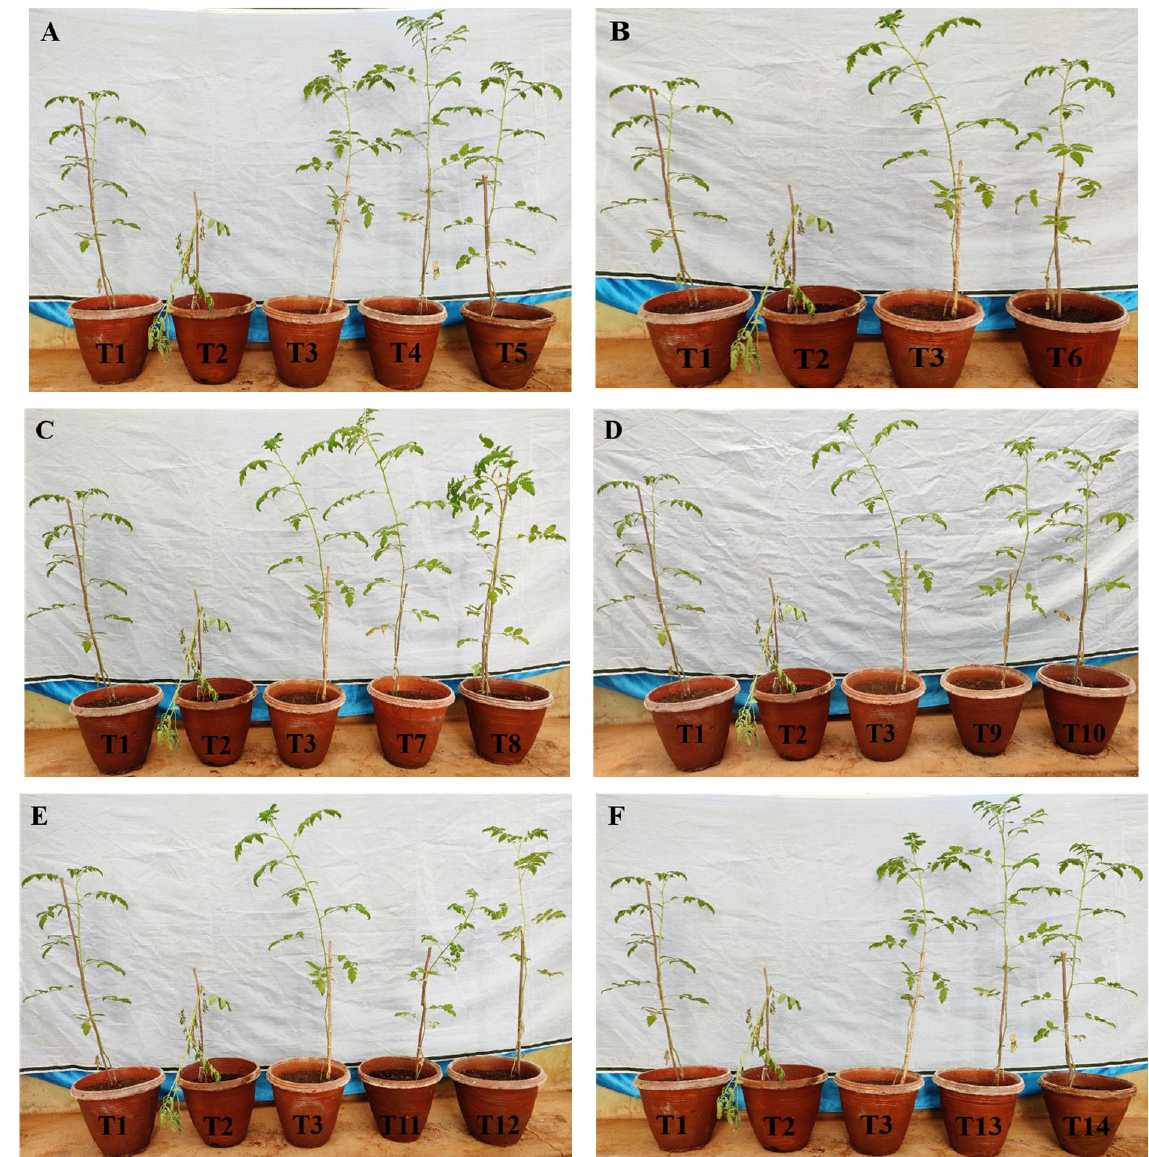
Figure 10. Biocontrol efficacy of P. fluorescens and 2,4-DAPG against bacterial wilt pathogen R. solanacearum in tomato plants under greenhouse conditions. ( A ) T1-control, T2- R. solanacearum alone, T3-Tetracycline, T4- P. fluorescens (Pf), T5- P. fluorescens culture filtrate (CF); ( B ) DAPG compound treated plants (T6); ( C ) soil application of Pf and CF (T7&T8); ( D ) root dipping method of Pf and CF (T9&T10); ( E ) seed treatments of Pf and CF (T11&T12); ( F ) foliar spray methods of Pf and CF (T13&T14) treated with tomato plants.